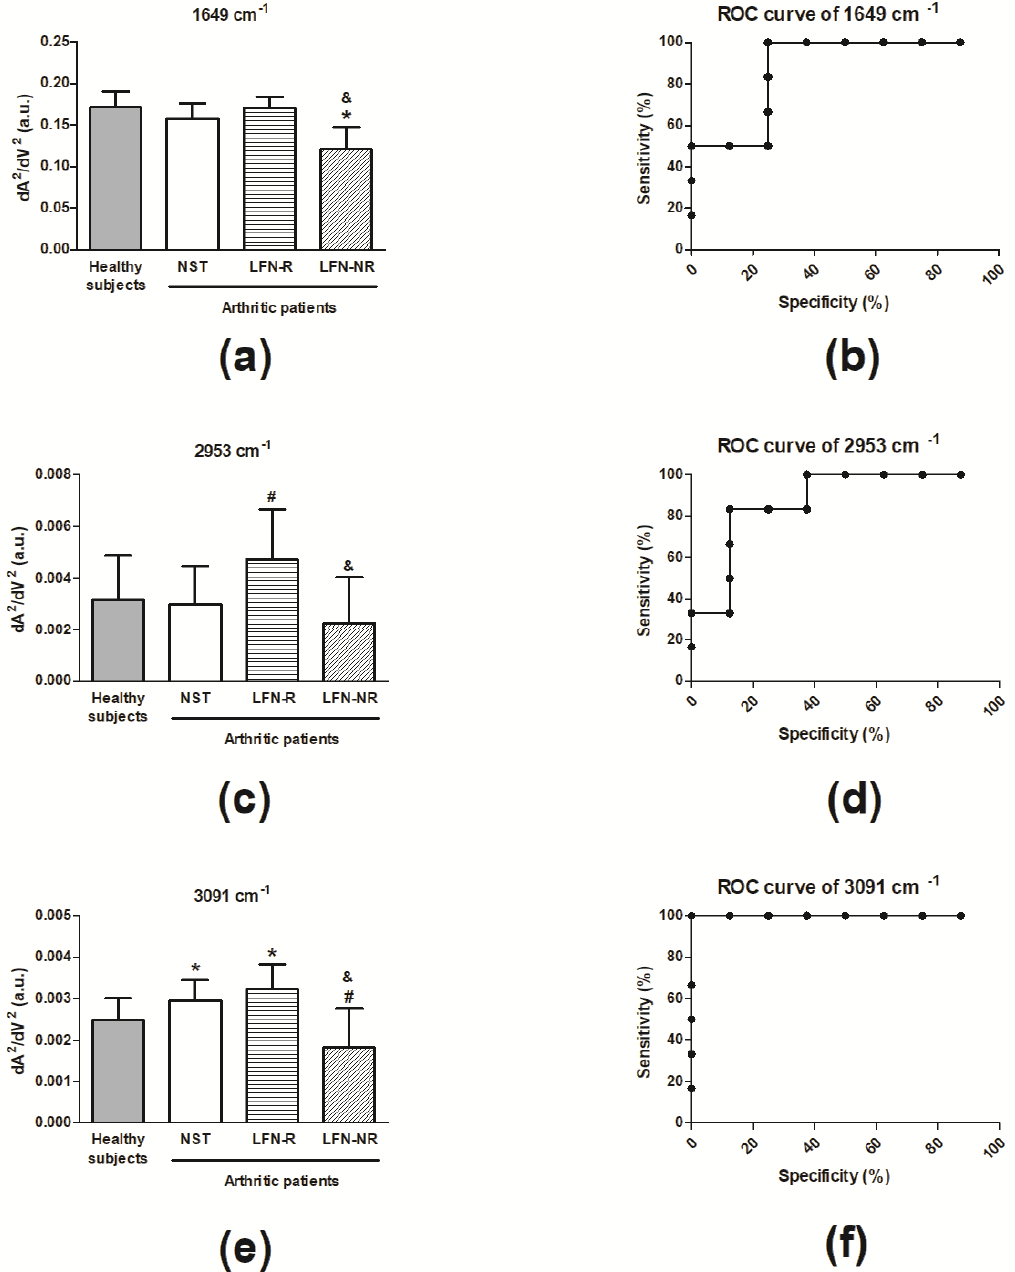
Figure 5. Vibrational mode values in plasma samples of rheumatoid arthritis (RA) patients. Vibrational modes at ( a ) 1649 cm − 1 , ( c ) 2953 cm − 1 and ( e ) 3091 cm − 1 from plasma samples of RA patients. ROC curve analysis of ( b ) 1649 cm − 1 , ( d ) 2953 cm − 1 and ( f ) 3091 cm − 1 to LFN-R and LFN-NR individuals. Samples were obtained from patients recently diagnosed with rheumatoid arthritis (RA) but not yet receiving specific treatment with anti-rheumatic drugs, prior to leflunomide (LFN; 20 mg/day, per os ) treatment (NST group; n = 14). Three-months following treatment, samples were collected from both responders (LFN-R; n = 8) and non-responders (LFN-NR; n = 6) to LFN. Healthy subjects ( n = 10) were used as controls. Data are expressed as mean ± SD (panels a , c and e ). ∗ p < 0.05, differs from healthy subjects; # p < 0.05, differs from the NST group; & p < 0.05, differs from the LFN-R group.